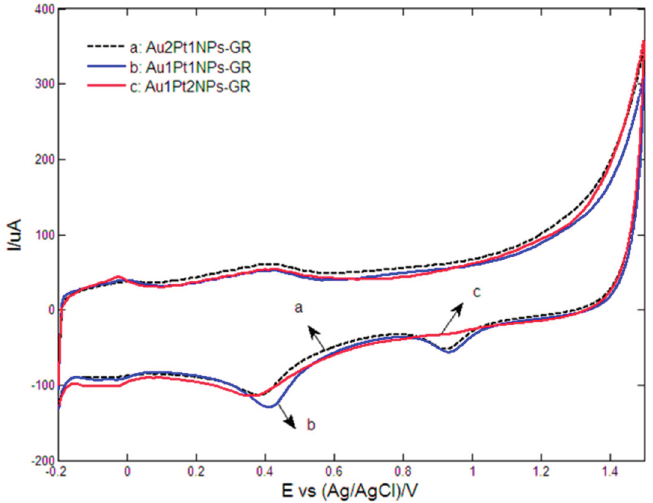
Figure 2. Cyclic voltammograms of ( a ) Au2Pt1NPs-GR; ( b ) Au1Pt1NPs-GR and ( c ) Au1Pt2NPs-GR nanocomposites modified electrodes in 0.5 M H 2 SO 4 at scan rates of 100 mV/s.